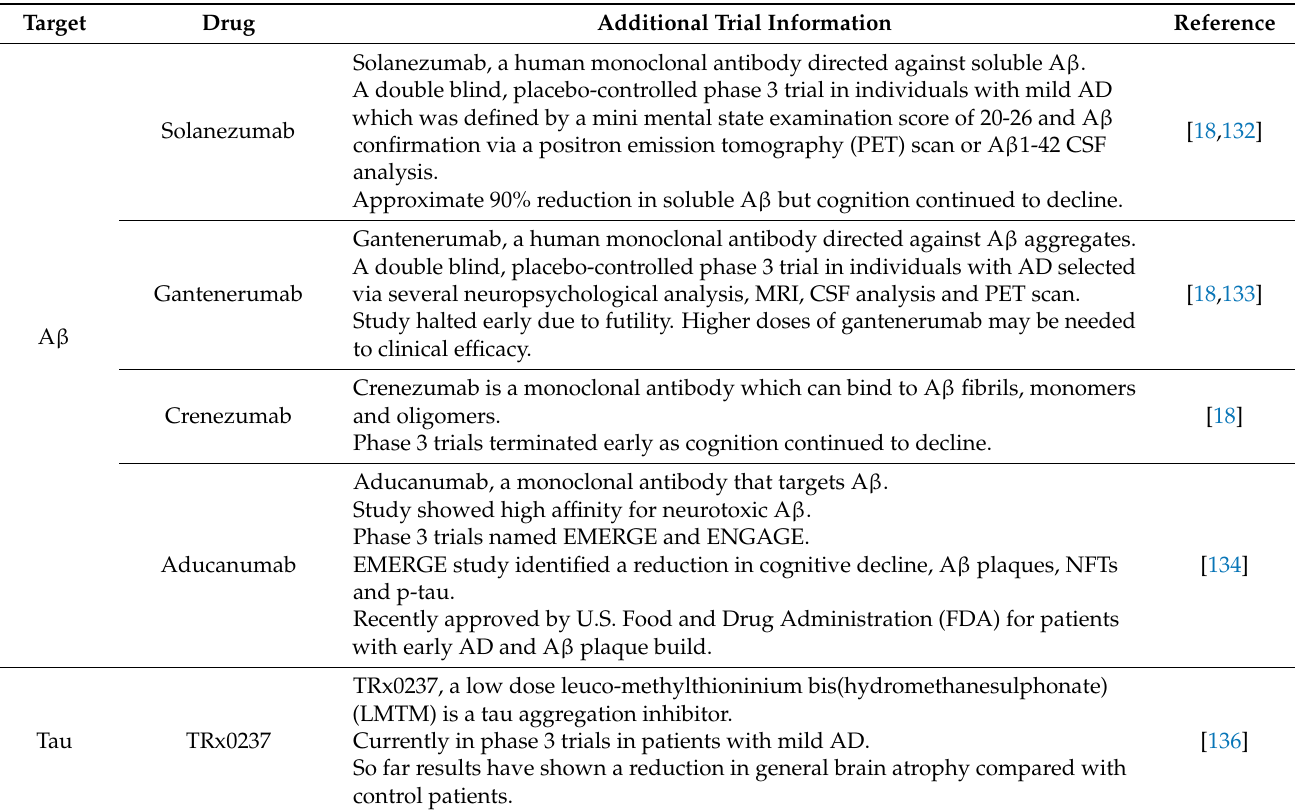
Table 2. Summary of the clinical trials for treating